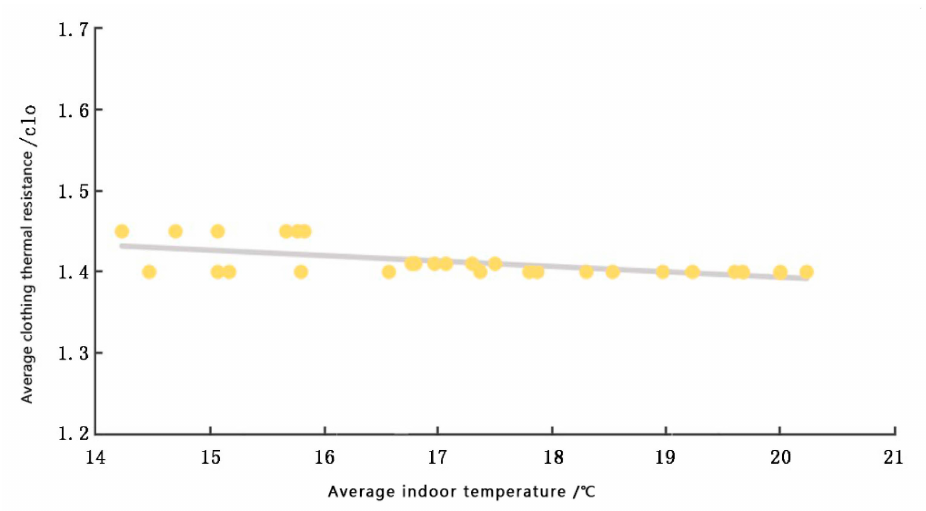
Figure 12. Indoor temperature–garment thermal resistance graph (source: self-drawn).